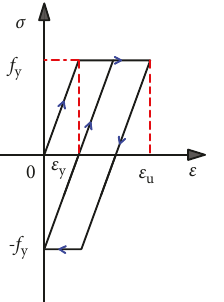
Figure 5: The constitutive relationship of RED